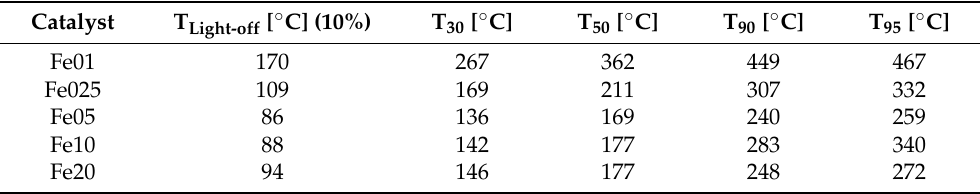
Table 6. Temperatures of Fe01 to Fe20 corresponding to light-off, 30%, 50%, 90%, and 95% CO conversion, respectively CO 2 yield, obtained from measurements with continuous heating. Light-off was defined as the point of 10% CO conversion.